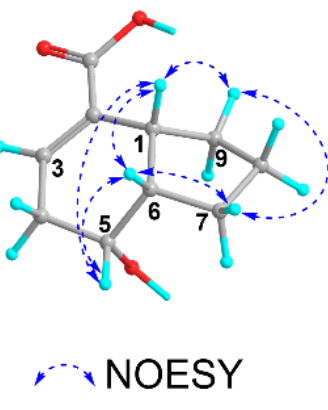
Figure 2. Key COSY, NOESY and HMBC correlations of 1 .